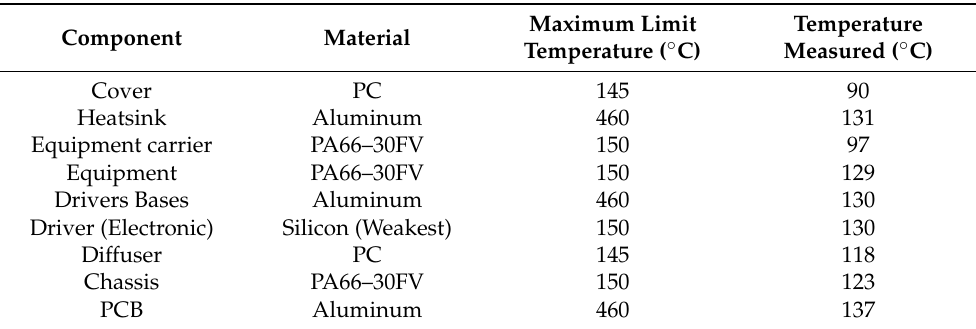
Table 4. Maximum temperature limit of the material versus temperature measured in the different parts of the Model at 40 ◦ C. Source: our own elaboration.